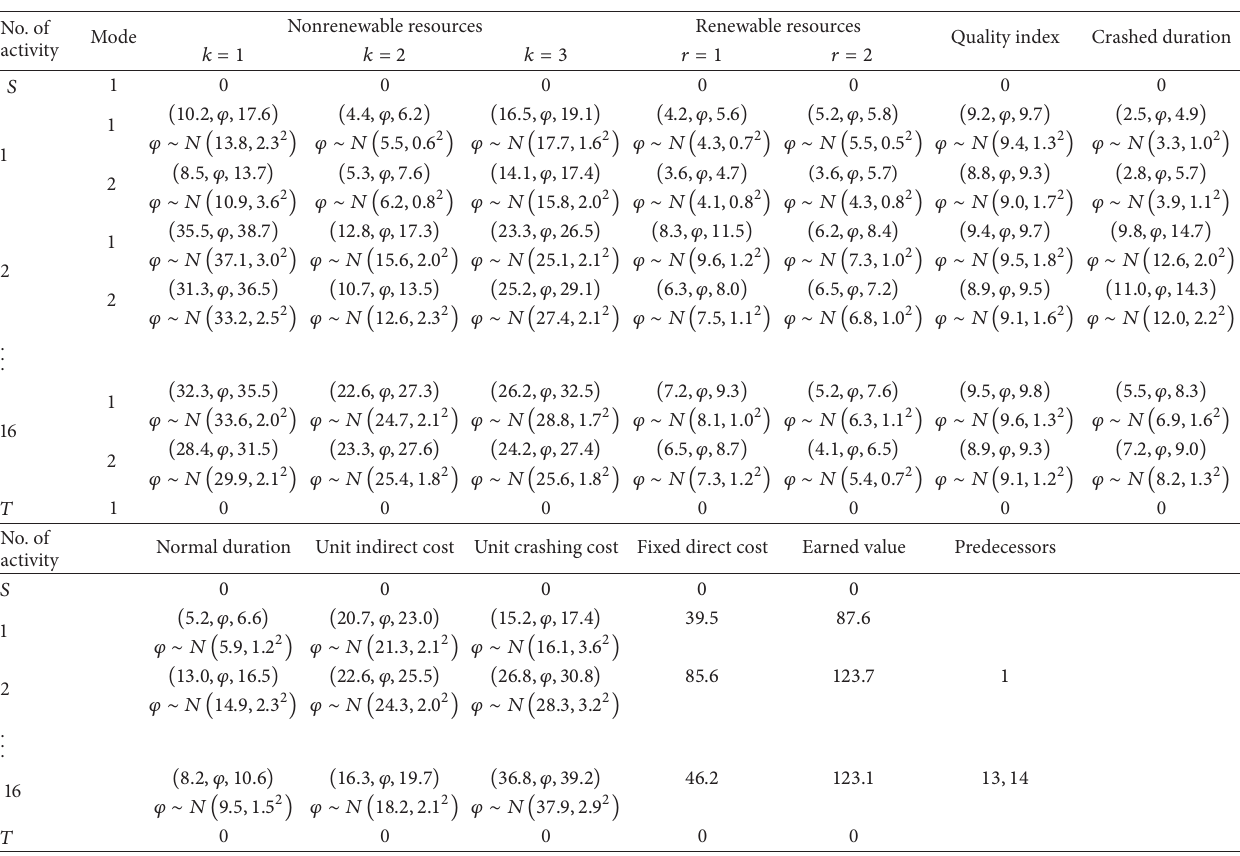
Table 1: Detailed information of each activity in the river diversion construction